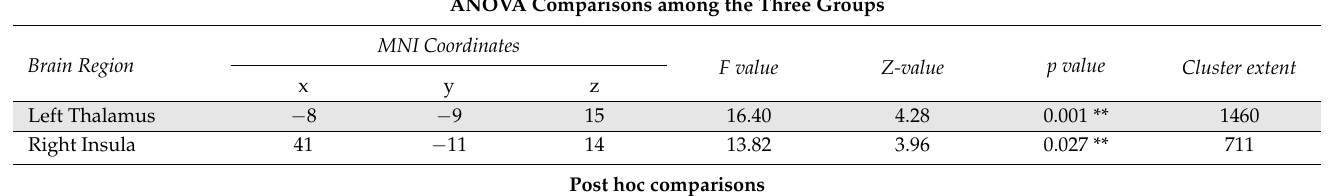
Table 2. Structural covariance analysis. Seed region: Left Caudate.